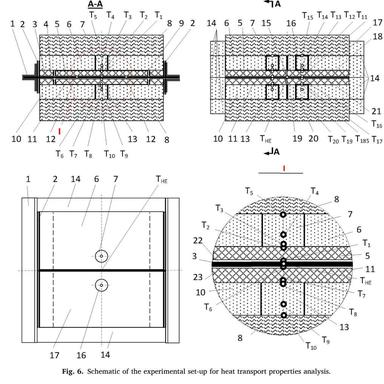
CTE behavior of C/C coated by Al2O3 naked varnish (left) and of C/C coated by Al2O3 enriched by 1 wt% of SiO2 nano-sphere inclusion (right).